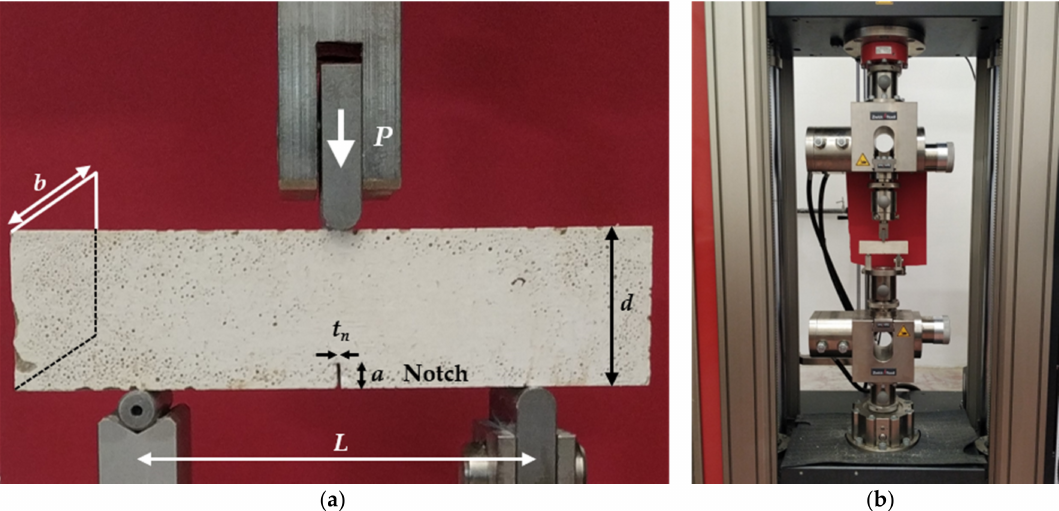
Figure 7. 3PBT carried out at the LPMS of L’Aquila. ( a ) Notch geometry adopted in the tests; ( b ) setup of a specimen with the Zwick Roell hydraulic machine used for applying the load under displacement